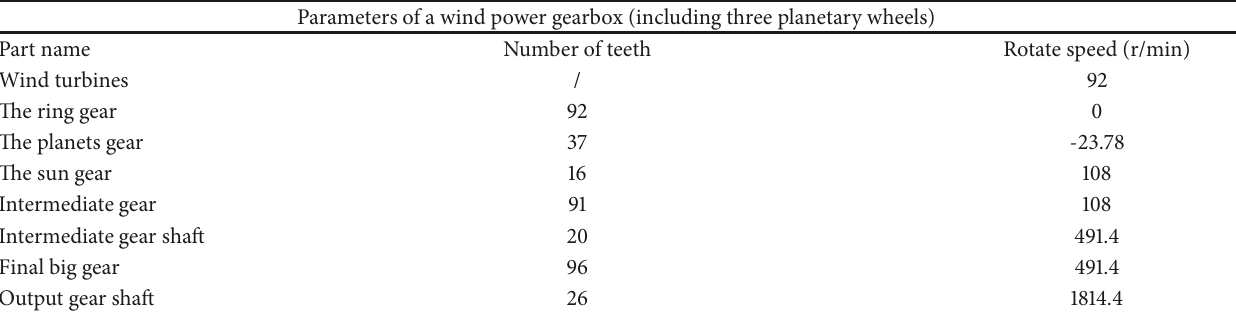
Table 3: Parameters of wind power gearbox under a certain actual working